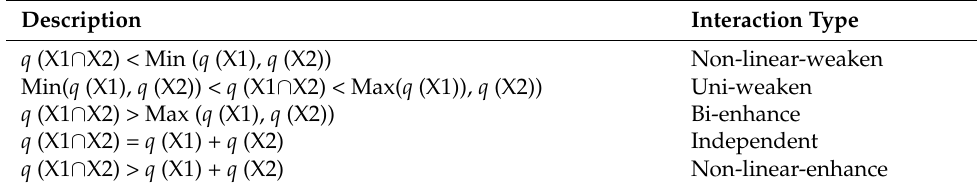
Table 7. Interaction Detector